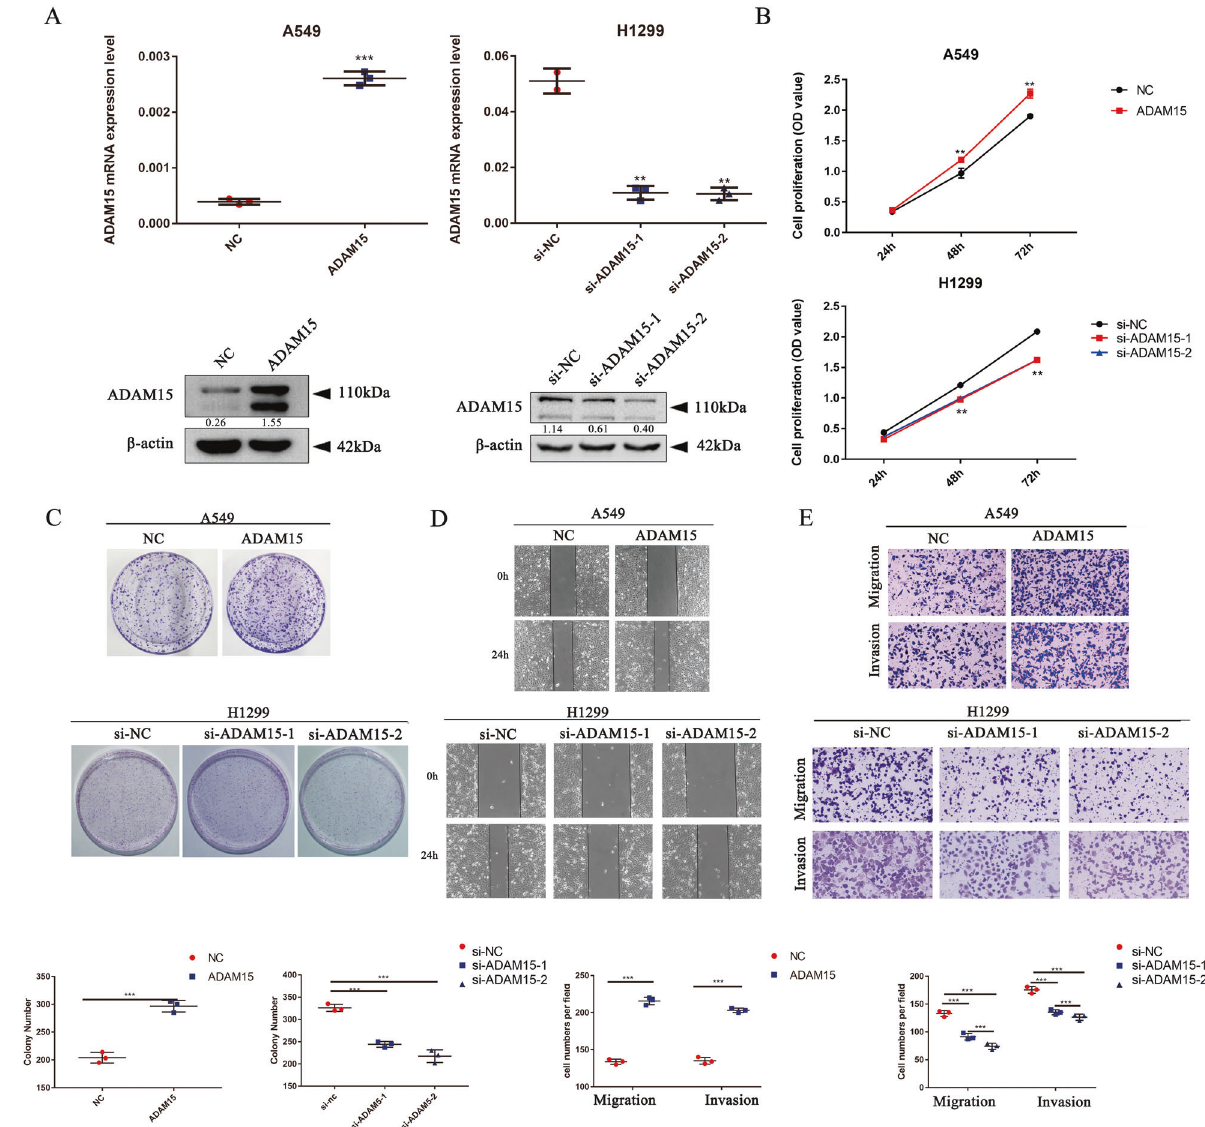
Fig. 2 ADAM15 affects NSCLC cell proliferation, migration and invasion in ADAM15-overexpressing A549 cell lines and ADAM15- knockdown H1299 cell lines. A ADAM15 mRNA and protein levels were detected in ADAM15-overexpressing A549 cell lines and ADAM15- knockdown H1299 cell lines. B , C CCK-8 and clonogenic assays of cell proliferation in A549 and H1299 cell lines. D A wound healing assay was performed to evaluate the effect of ADAM15 in A549 and H1299 cells. E Images of the Transwell assay results for cell migration and invasion in A549 and H1299 cells. Bars represent the mean ± SEM from three independent experiments. * P < 0.05; ** P < 0.01; *** P <